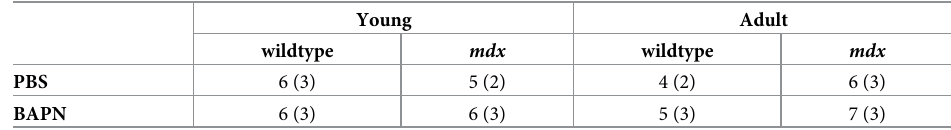
Table 1. Mouse sample